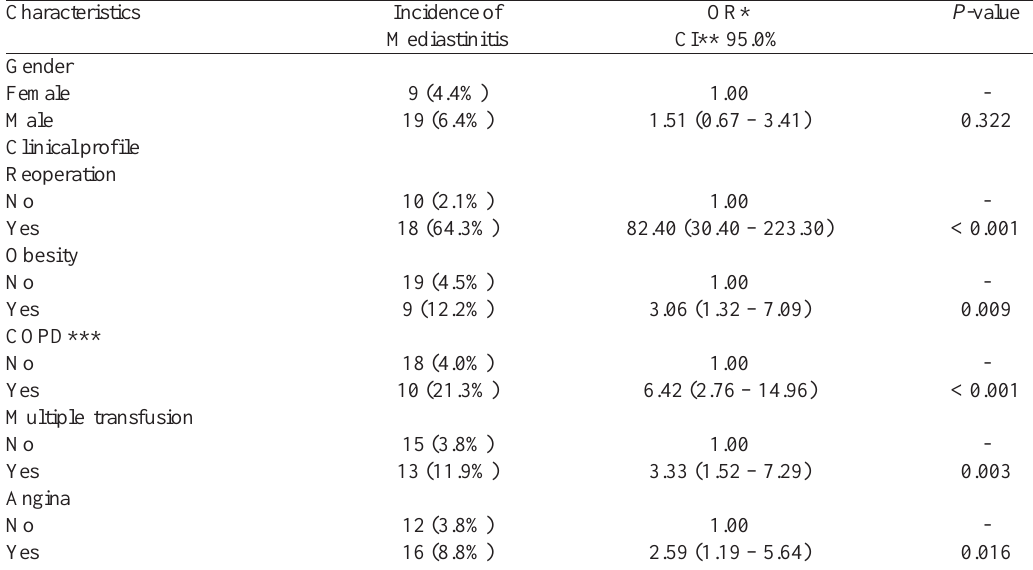
Table 3. Association of demographic and clinical characteristics with the occurrence of mediastinitis after CABG surgery (univariate analyses)